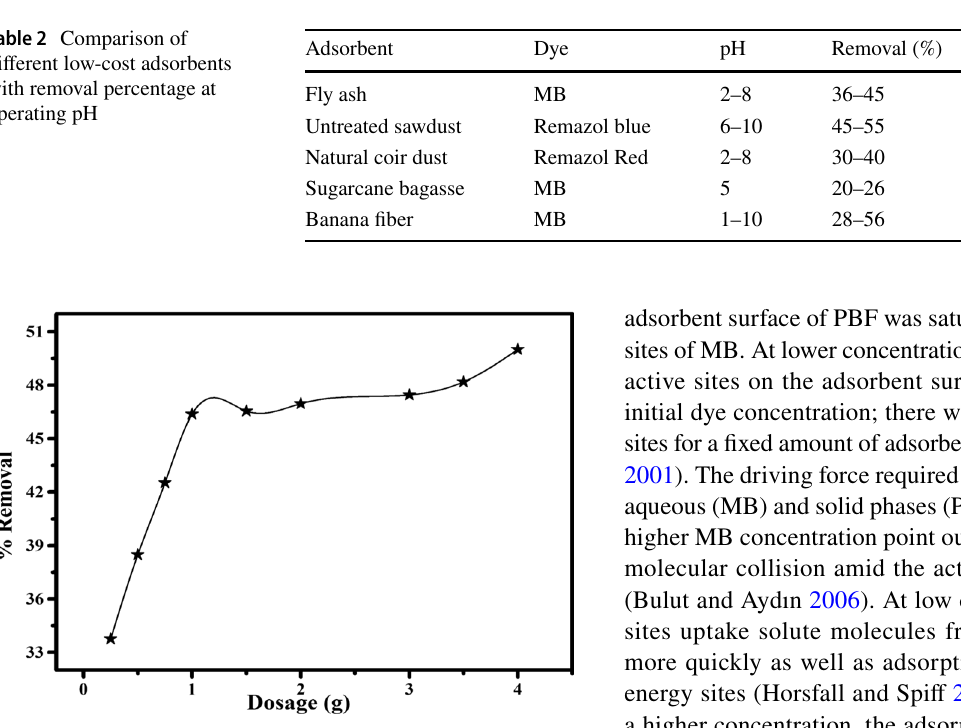
Fig. 4 Impact of PBF adsorbent dosage for MB dye removal from